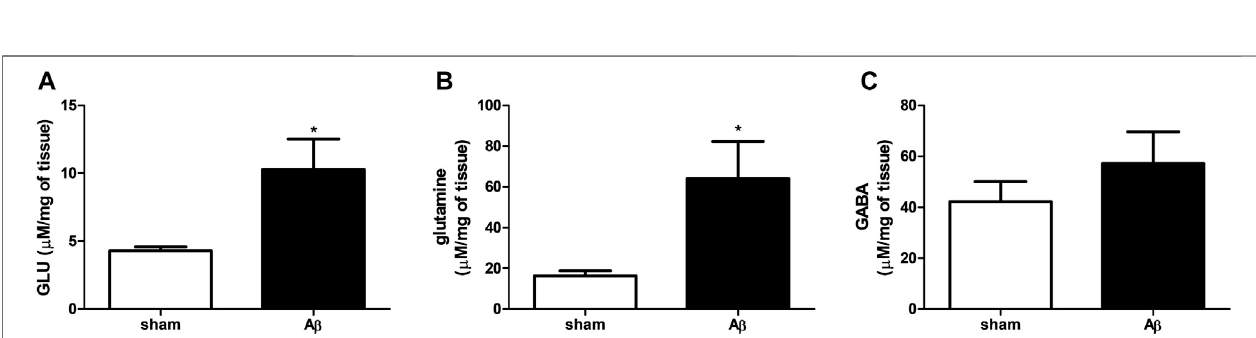
FIGURE4| EffectsofA β administrationonhypothalamicGLU,glutamineandGABAlevels. (A) GLU( μ M/mgoftissue)insham(n (cid:1) 5)andA β -treated(n (cid:1) 6)animals. UnpairedStudent ’ st-test,* p < 0.05. (B) Glutamine( μ M/mgoftissue)insham(n (cid:1) 5)and A β -treated (n (cid:1) 6)animals.UnpairedStudent ’ st-test,* p < 0.05. (C) GABA( μ M/ mg of tissue) in sham (n (cid:1) 5) and A β -treated (n (cid:1) 6) animals. Unpaired Student ’ s t-test, p > 0.05 A β vs sham.